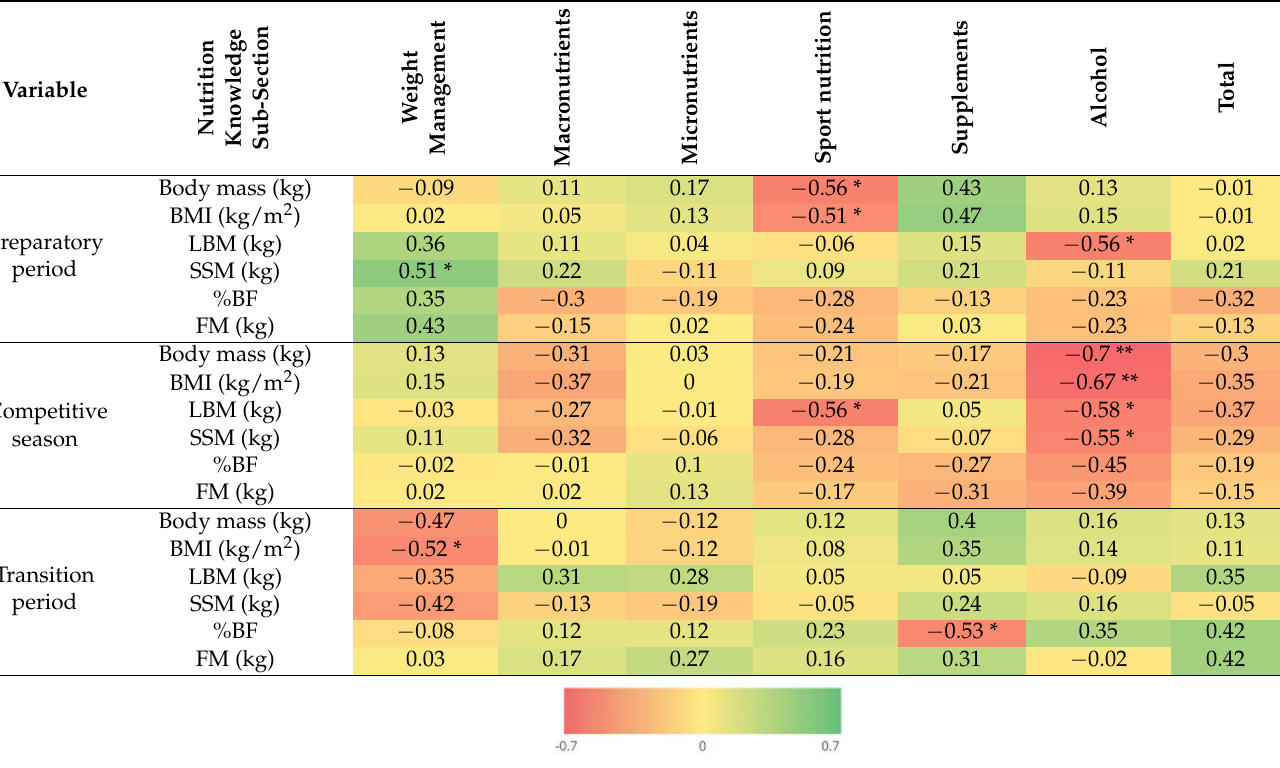
Table 2. Heat map of the strength of the correlation of differences in maximum and minimum body composition measurements and level on the nutrition knowledge assessment expressed by Spearman’s R’ correlation coefficient in the 19–25 age group. The results are visualized using a false color scale, where red indicates a negative correlation and green a positive